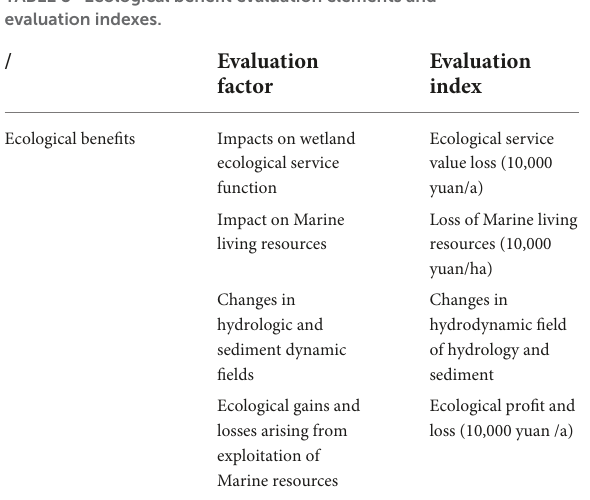
(Huang et al., 2021; Xie et al., 2021). The factors and indexes of economic benefit evaluation are shown in Table 7